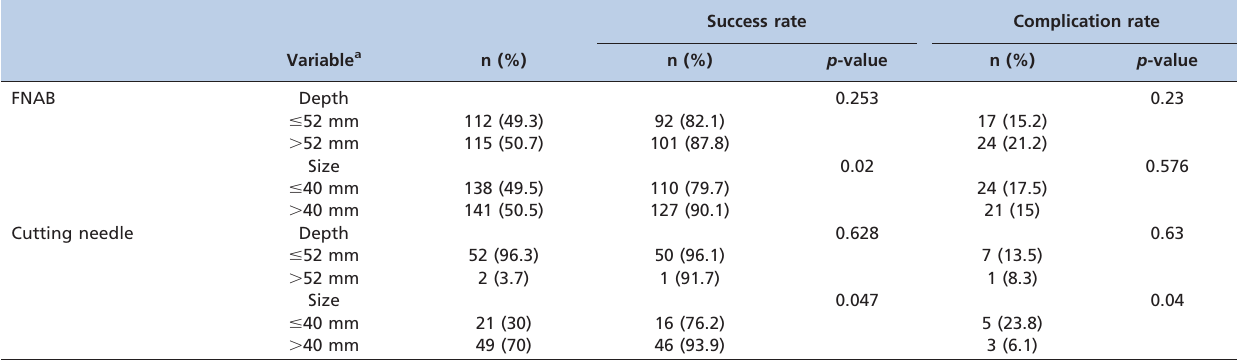
Table 2 - Success and complication rates of FNAB and cutting-needle biopsy according to lesion depth and